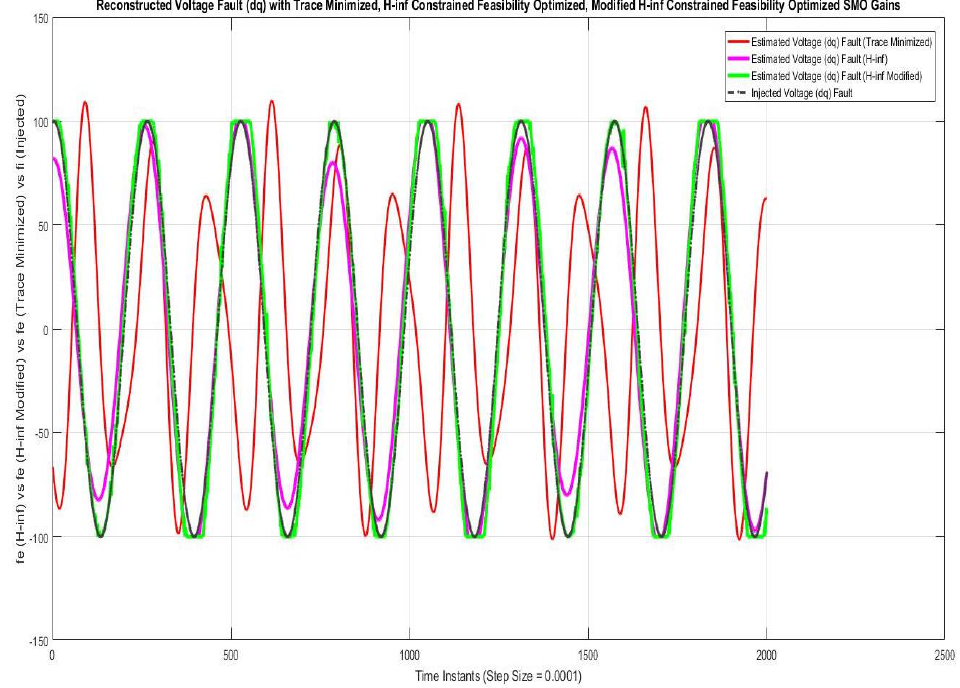
Figure 8. Voltage (dq) fault reconstruction.